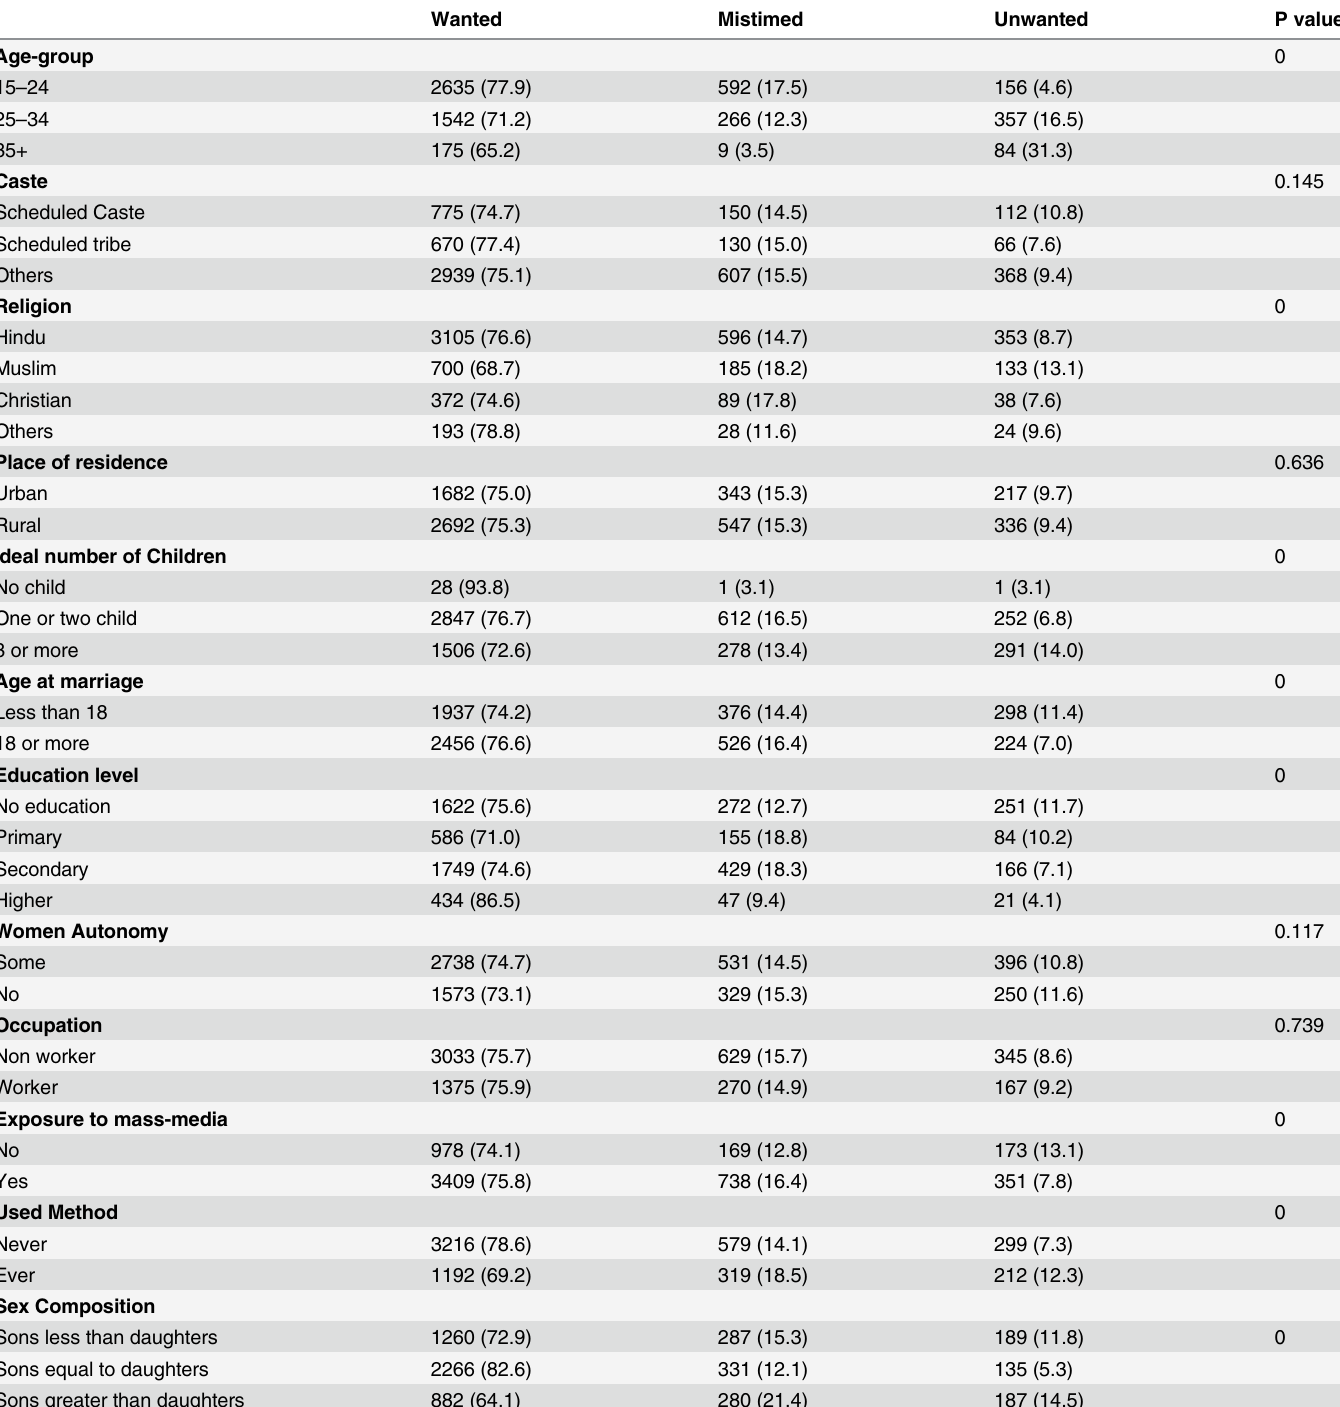
Table 1. Number and Percent distribution of pregnancy intentions by women ’ s characteristics Pregnancy Intention n (%). Wanted Mistimed